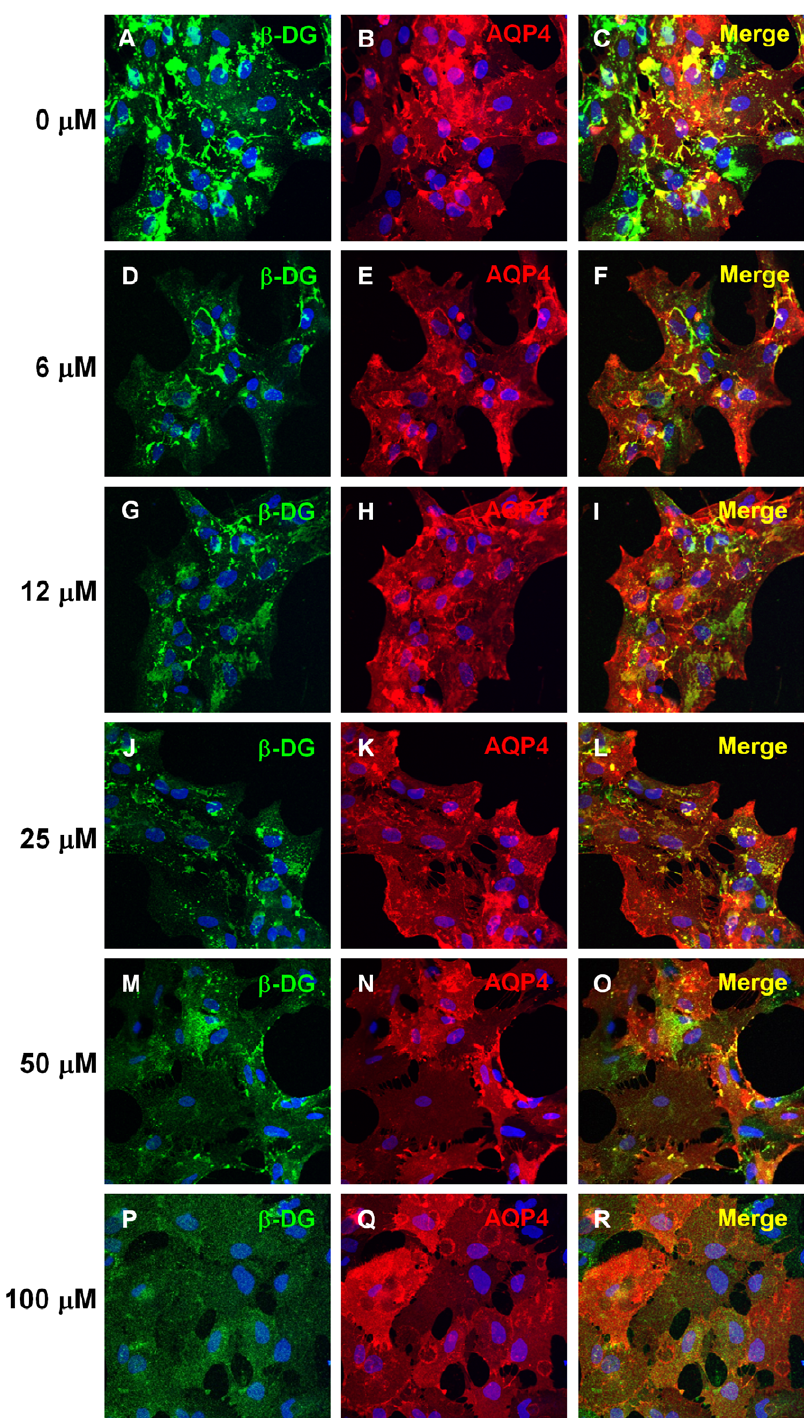
Figure 4. Effect of chloranil on the laminin-induced co-clustering of ß-DG and AQP4. Primary astrocytes were treated for 7 h with 20 nM laminin and15 m M chloranil during the last 4 h. The concentration of chloranil varied from 0 (A,B,C), 6(D,E,F), 12(G,H,I), 25 (J,K,L), 50 (M,N, O) to 100 m M (P,Q,R). The cells were fixed and labelled for m -DG (A, D, G, J, M and P) and AQP4 (B, E, H, K, N and Q). Clustered staining was quantified using confocal microscopy. Scale bar, 30 m m.